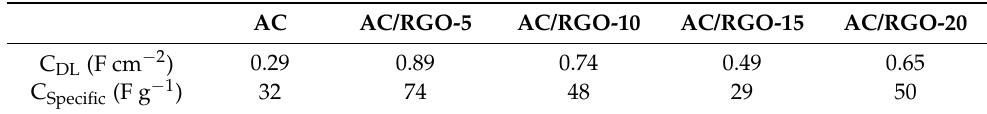
Table 2. Calculated double layer capacitance (C DL ) and specific capacitance (C Specific ) for AC and AC/RGO-x